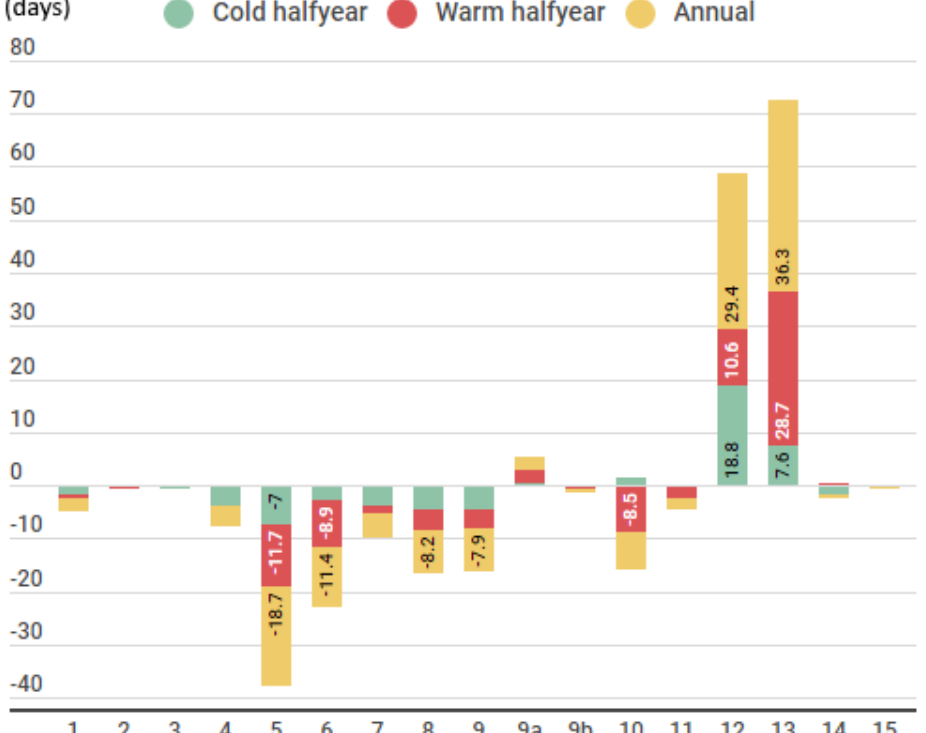
Table 1. Classification of SWT over Middle Asia during the warm and cold half-year in the percentage of days over 1961–1990 years.